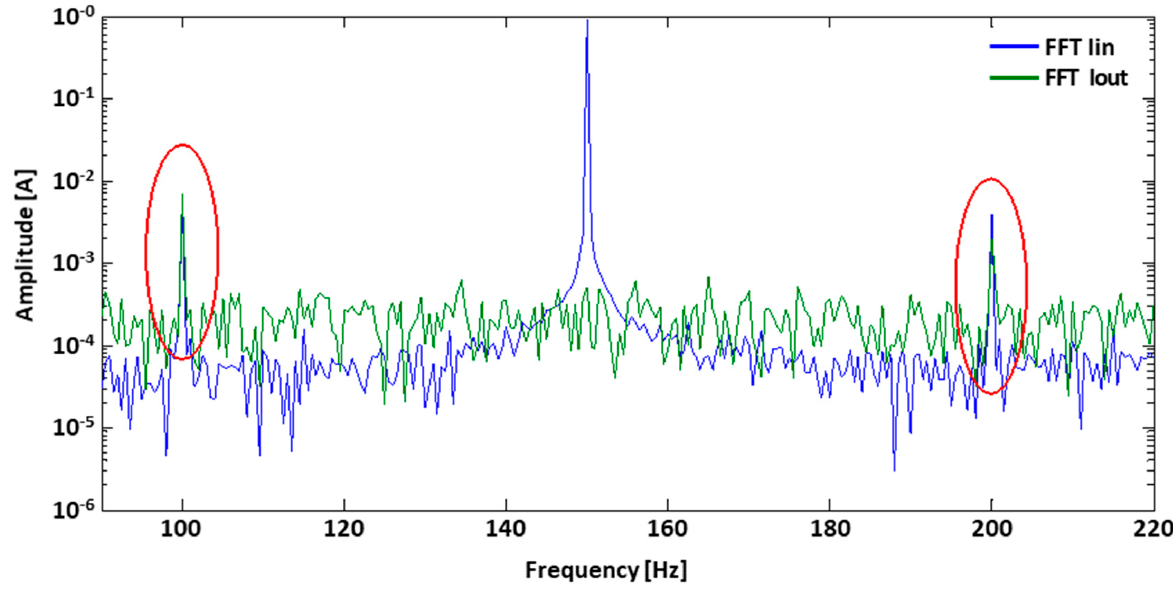
Figure 11. Link between harmonics of voltage on AC ( Vin ) and DC ( Vout ) sides.